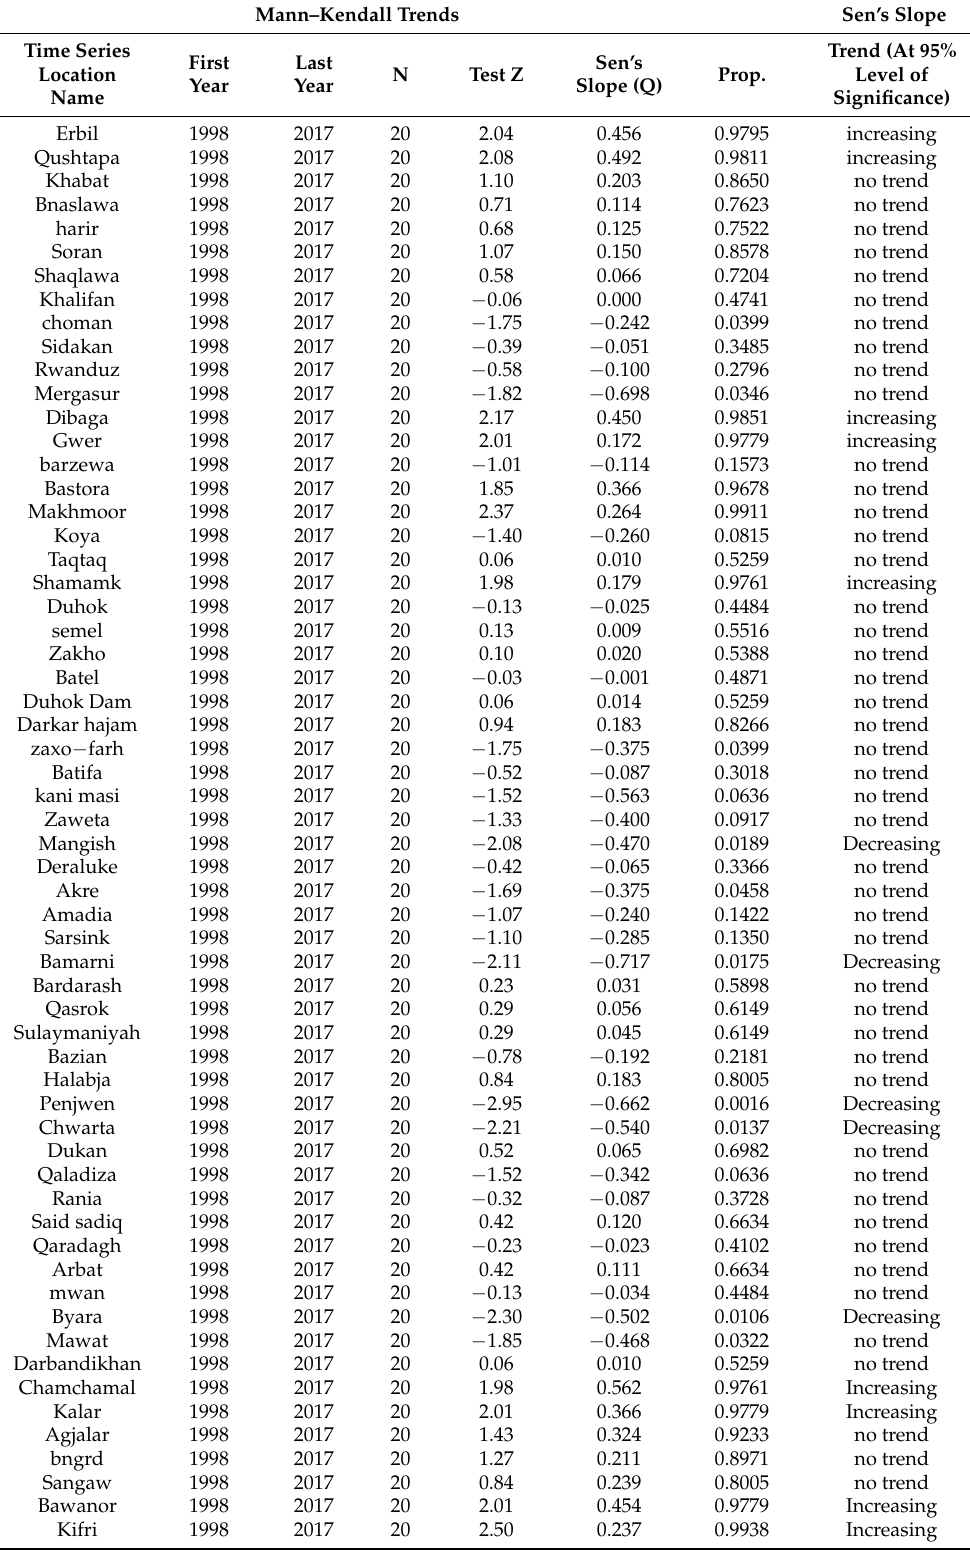
Table 7. LST trends in the KRI over the 20 years using the Mann–Kendall Test and Sen’s slope